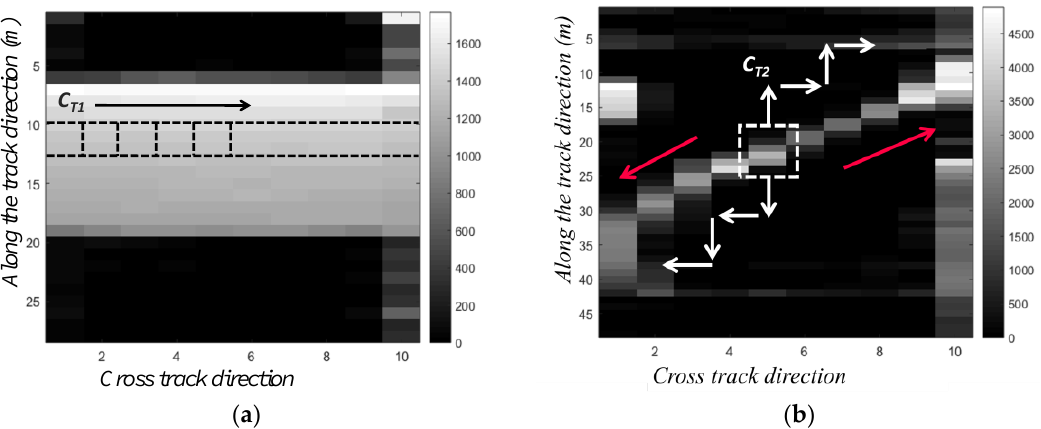
Figure 8. Apply the proposed method to the real dataset near the ( a ) rail crossing and ( b ) turnout in the 2D plane.